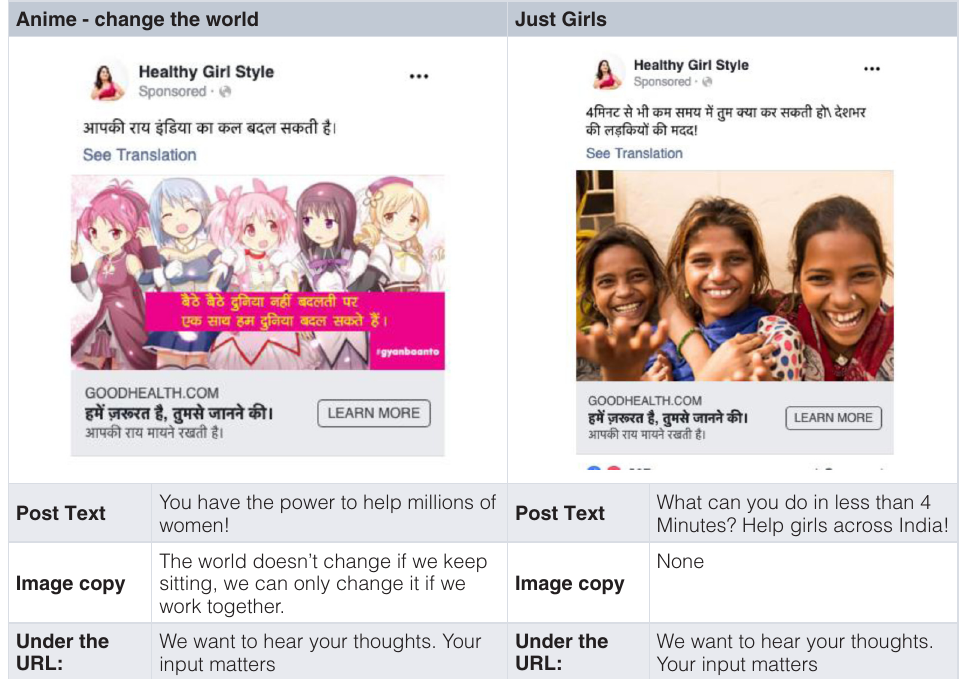
Table 3. Top performing campaign creative